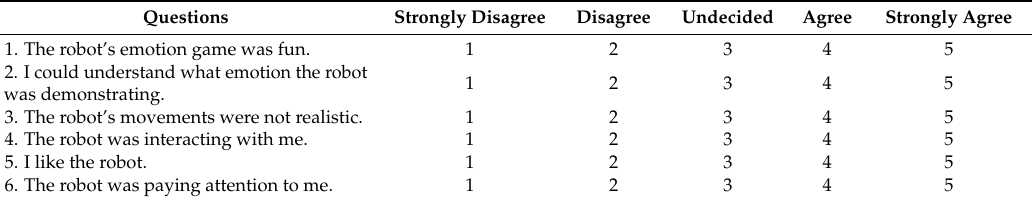
Table A7. Post-survey section 1/1.